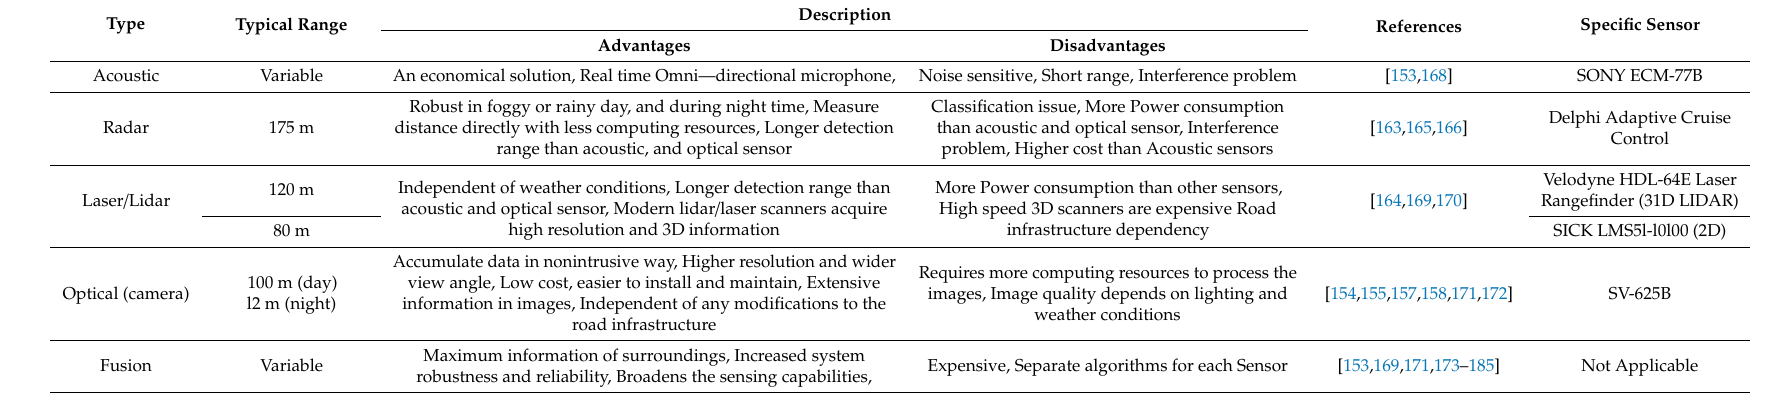
Table 3. A survey of sensors applicable in the field of vehicle detection and tracking